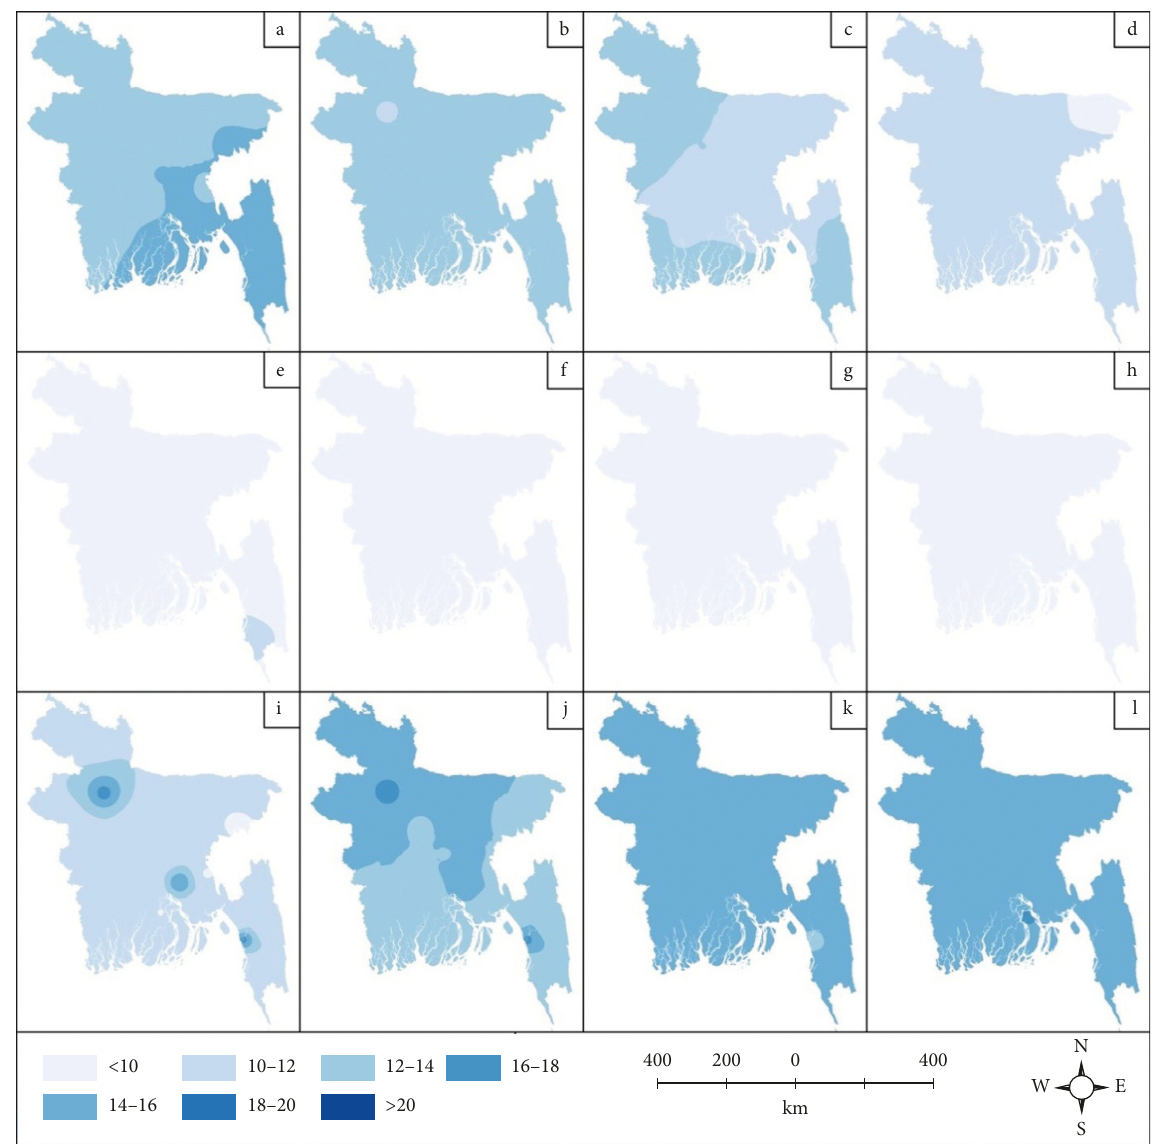
Figure 4: Mean two-month PCI during (a) JF; (b) FM; (c) MA; (d) AM; (e) MJ; (f) JJ; (g) JA; (h) AS; (i) SO; (j) ON; (k) ND; (l)